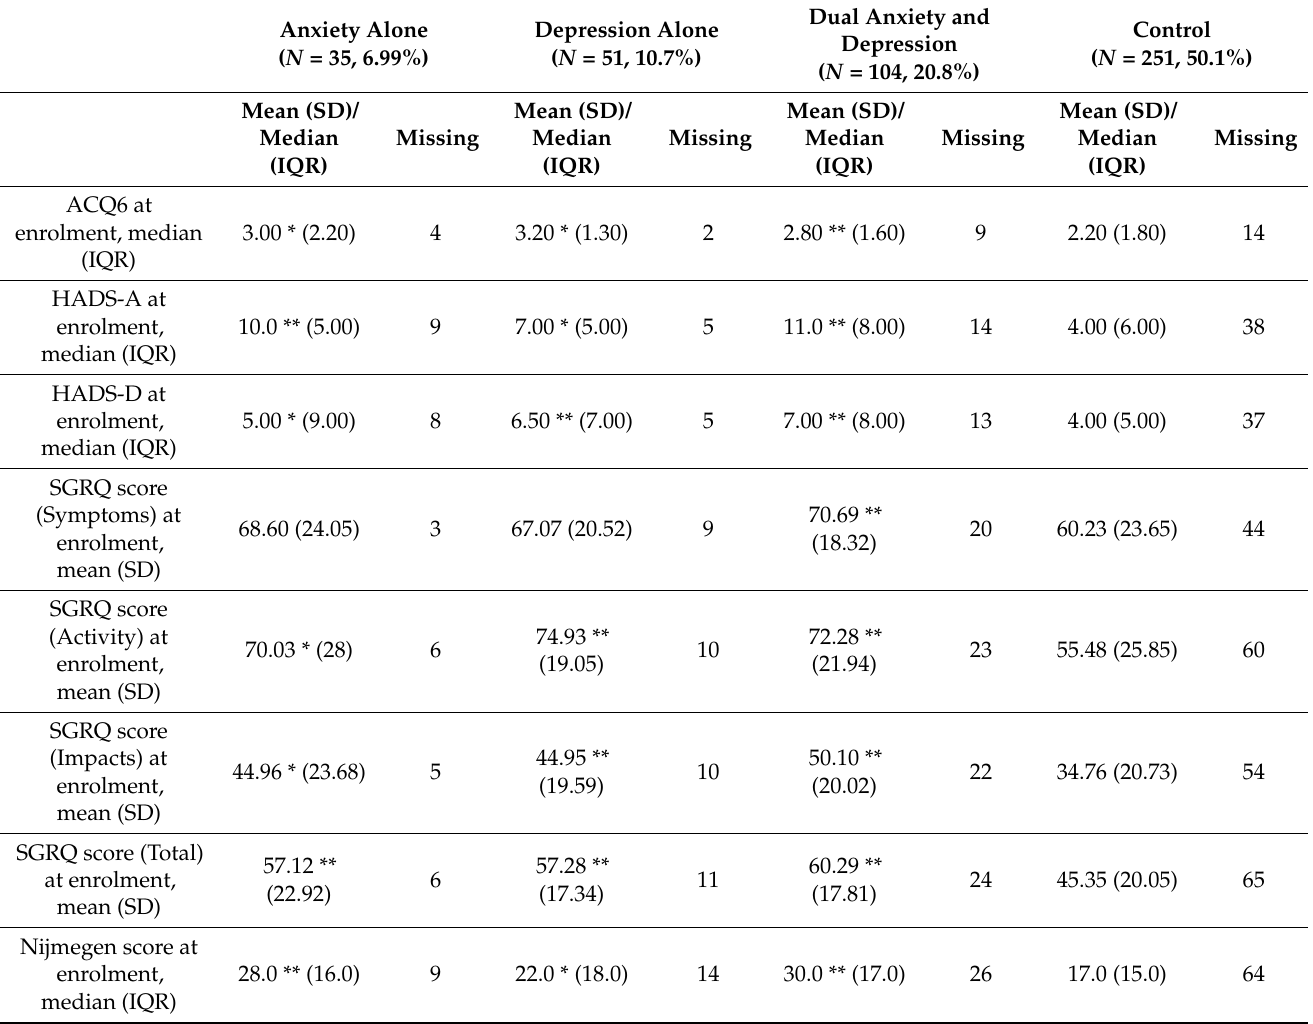
Control ( N = 251, 50.1%)